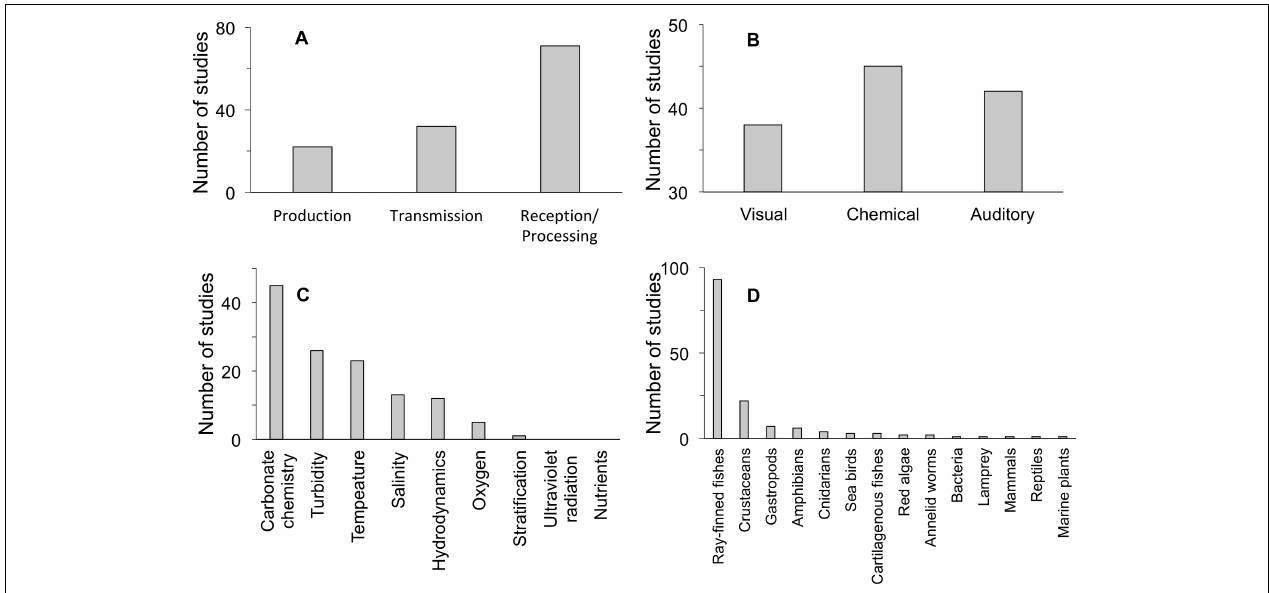
FIGURE 2 | Evidence for effects of global change on sensory pathways, divided by (A) pathway step, (B) sensory modality, (C) environmental factor, and (D) taxonomic group. Relevant freshwater examples are included in the tallies where no marine studies were found: 2 in production, 3 in reception/processing, 2 in visual, 1 in chemical, 1 in auditory, 4 in oxygen, 1 in turbidity, 3 in ray-finned fishes, and 1 in amphibians. See Table 1 for more detailed results of the literature